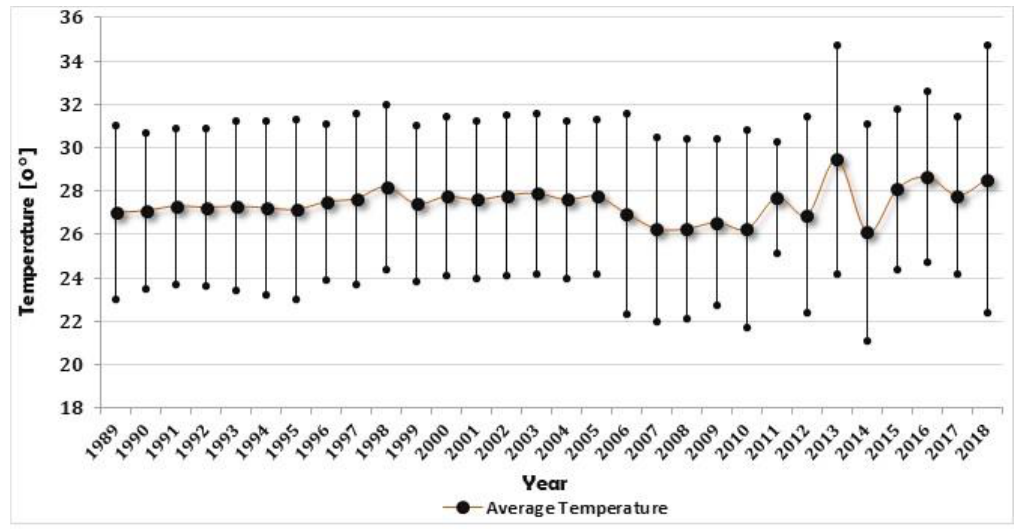
Figure 2. Average annual and corresponding minimum and maximum temperature for Lagos (1989 to 2018).